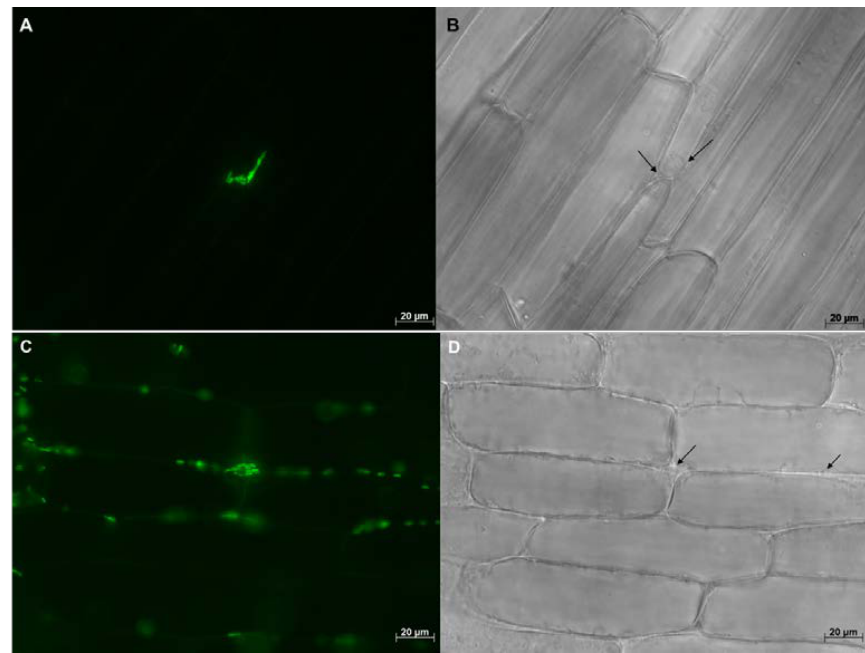
Figure 3. Maize (hybrids 14A91 and 29B17) roots were colonized by WP5 gfp and visualized under 630× magnification. Image on the left ( A , C ) were taken with the GFP filter, and images on the right ( B , D ) were taken without the GFP filter. WP5 gfp cells were observed in the middle lamella areas of the transverse wall between two adjacent cells. Microorganisms 2017 , 5 , 77 14 of 25